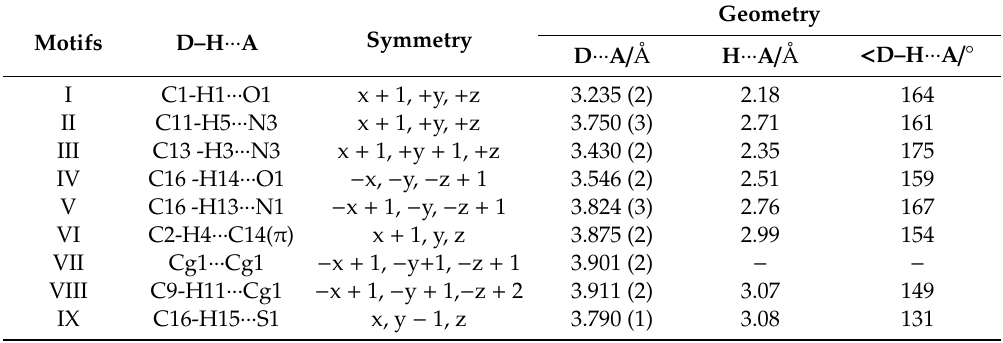
Table 4. Intermolecular interactions in GKV10: Cg1 refers to the center of gravity of the ring formed by